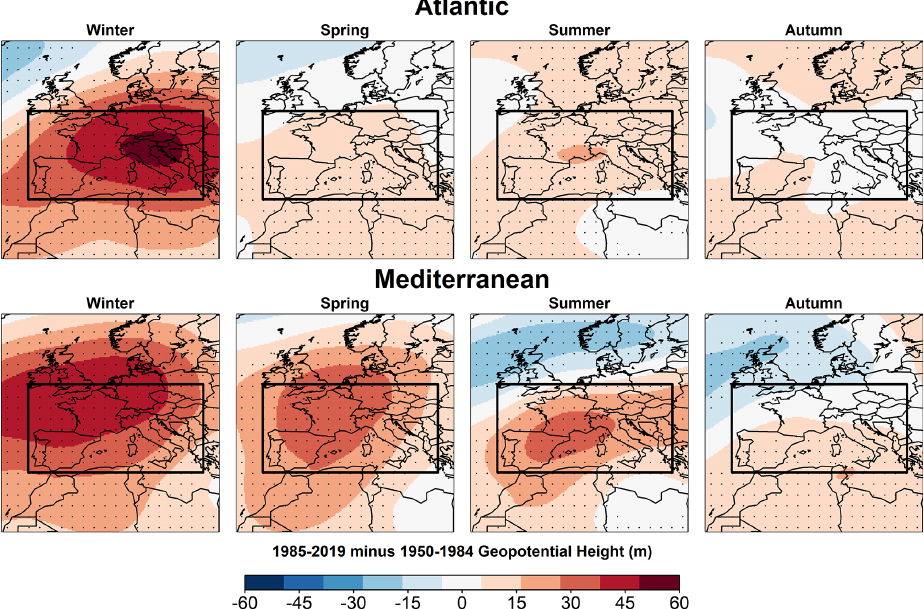
Figure 7. The 500hPa geopotential height difference (in m) between 1985–2019 and 1950–1984 according to the ERA5 reanalysis for Atlantic circulations and Mediterranean circulations, per season. The dots indicate significant differences between the two periods according to a two-sample t test ( p value < 5%). The western European region over which the atmospheric descriptors are computed is represented by the black rectangle. The maximum geopotential height difference displayed here reaches 60m. This corresponds to 30% of the maximum anomalies of 200m associated with the main atmospheric influences in Fig. 2b.